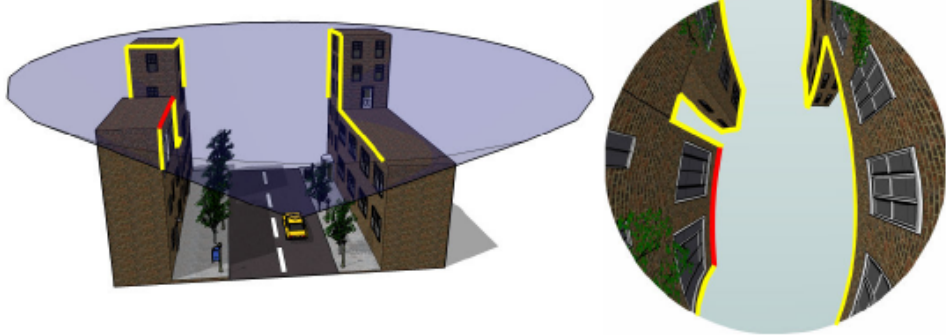
Figure 3. Fish-eye camera takes urban images and extracts